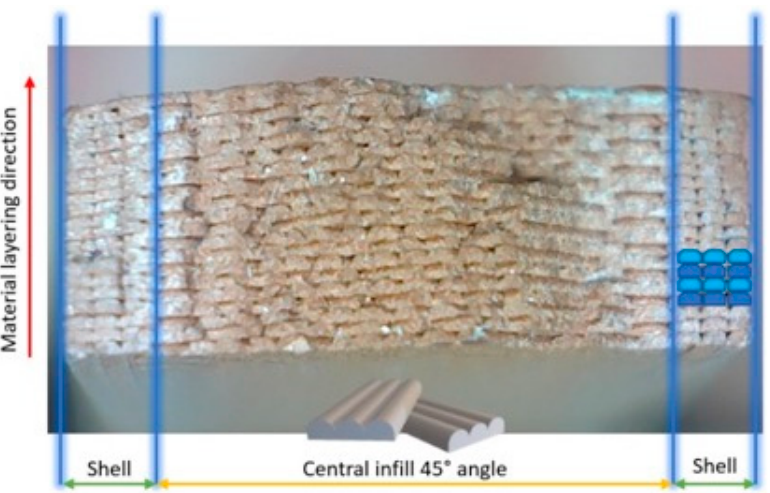
Figure 18. Internal structure of the